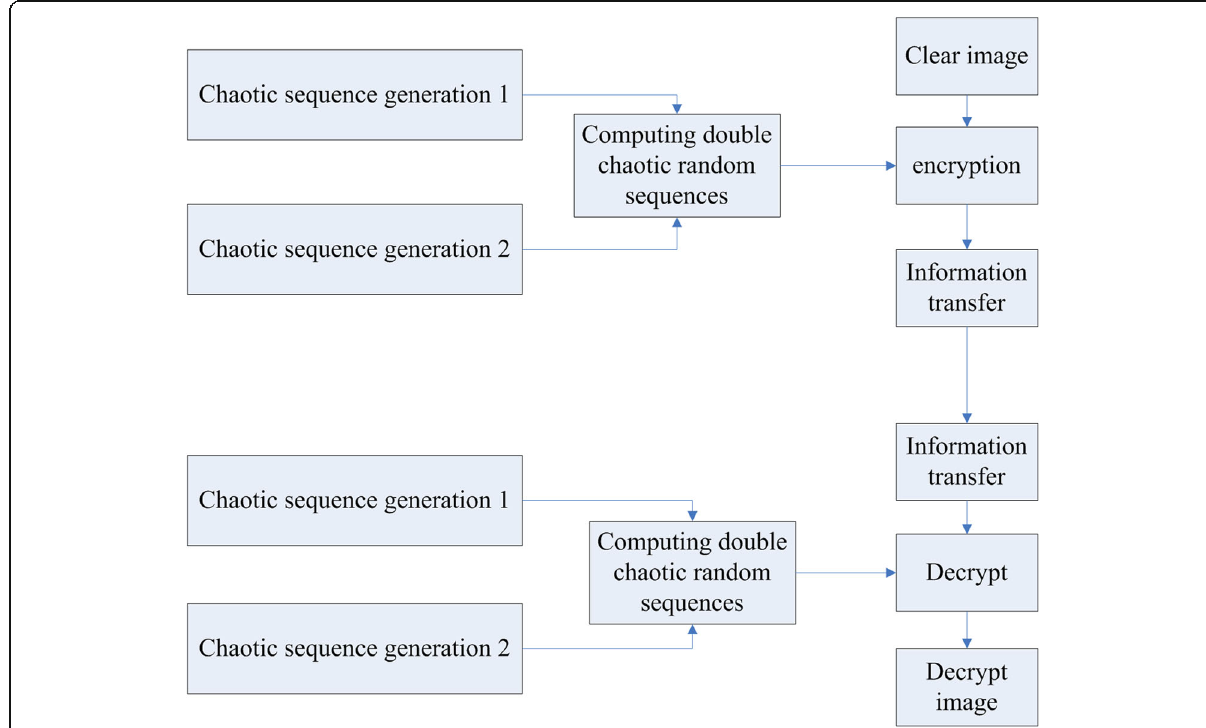
Fig. 1 Double chaotic image encryption